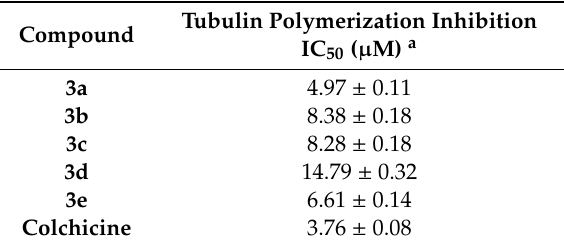
Table 4. Inhibition of tubulin polymerization displaying IC 50 ± standard error of the mean (SEM) ( µ M) for compounds 3a – e and colchicine as a